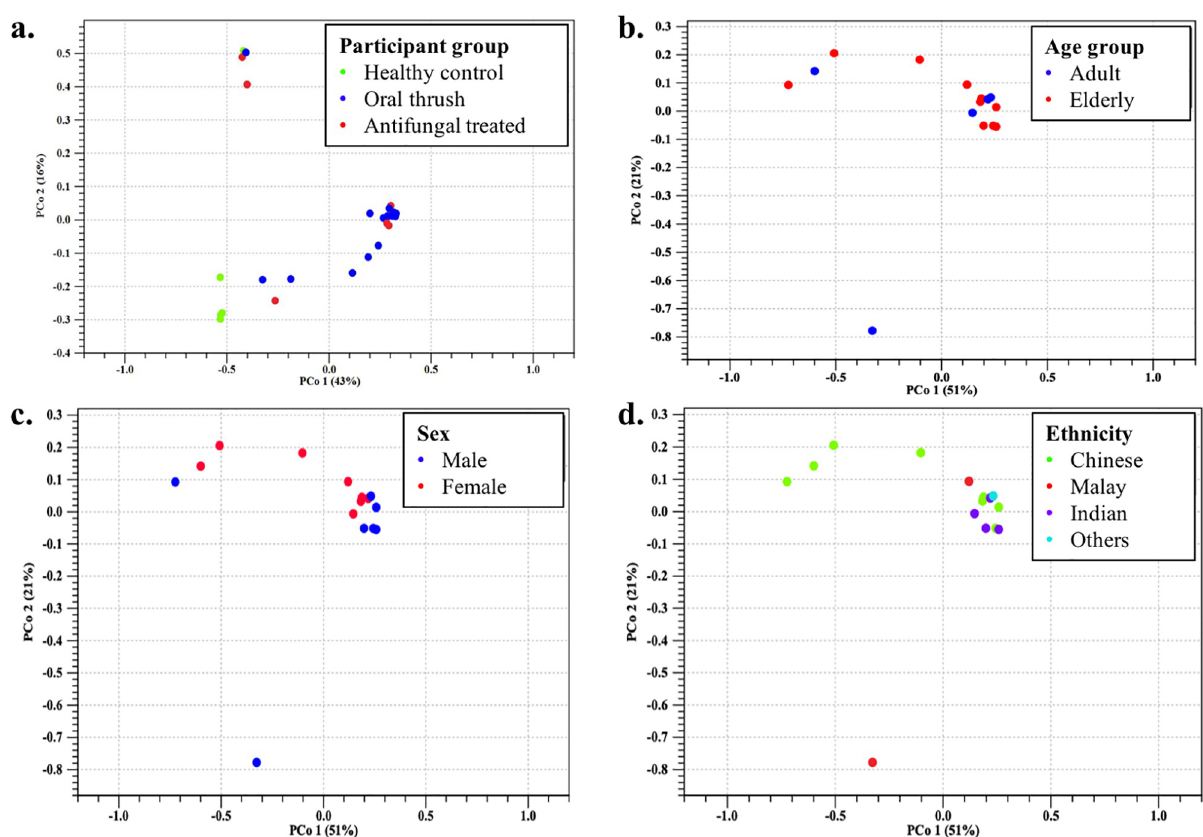
Fig 2. Beta diversity (Bray-Curtis) PCoA plots. The graph highlights the relationship between (a) OT, HC, and AT study groups. Pco1 (16%) and Pco2 (43%) examined the difference in oral mycobiota composition between oral rinse samples, with significant clustering evident in OT vs. HC participants (p = 0.02). Clinical variables such as (b) age, (c) sex, and (d) ethnicity were analyzed for OT patients, with no significant differences observed (p � 0.05).